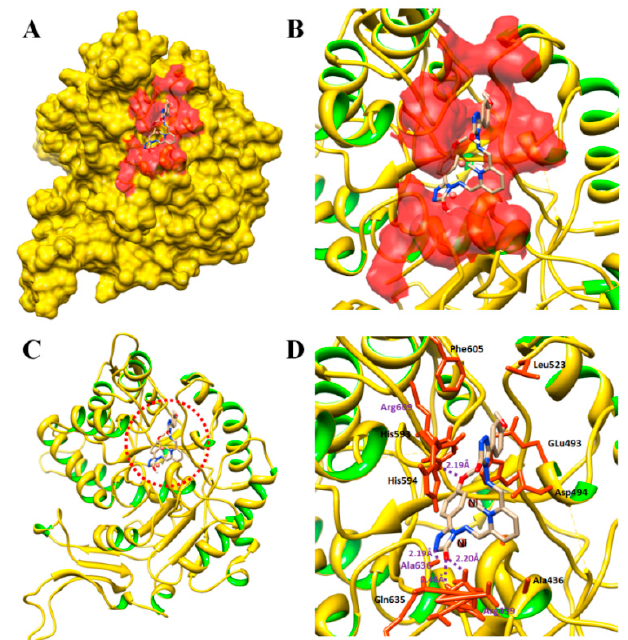
Figure 6. Docking results of 3a complex with jack bean urease. ( A ) the protein molecule is rendered as the yellow surface, whereas the binding pocket is highlighted in maroon. ( B ) The closer view of the docking complex with the 3a ligand. Two nickel atoms are labeled in brown. ( C ) The ribbon format protein structure with the interactive ligand. ( D ) The interactive residues are highlighted in the dark brown color and the ligand ( 3a ) is justified in grey color with different moieties’ colors. The purple lines represent hydrogen bonding and the distance mentioned in angstrom (Å).